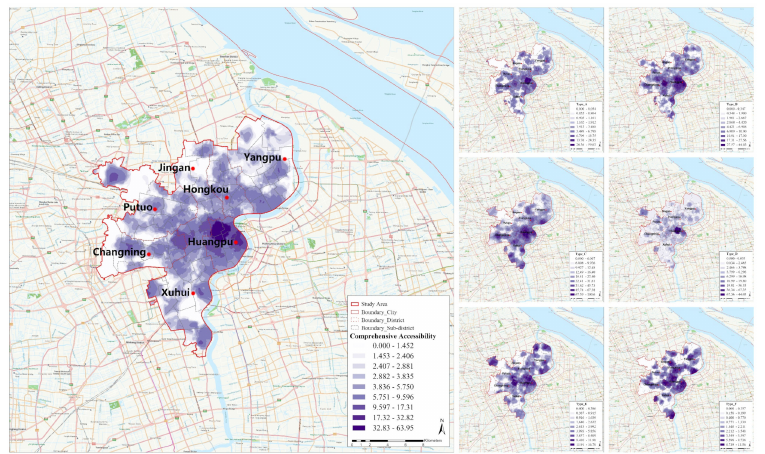
Figure 3. Kriging Interpolation diagram of accessibility results of community elderly care facilities. From left to right, from top to bottom, the comprehensive accessibility, the accessibility of Type-A, -B, -C, -D, -E,